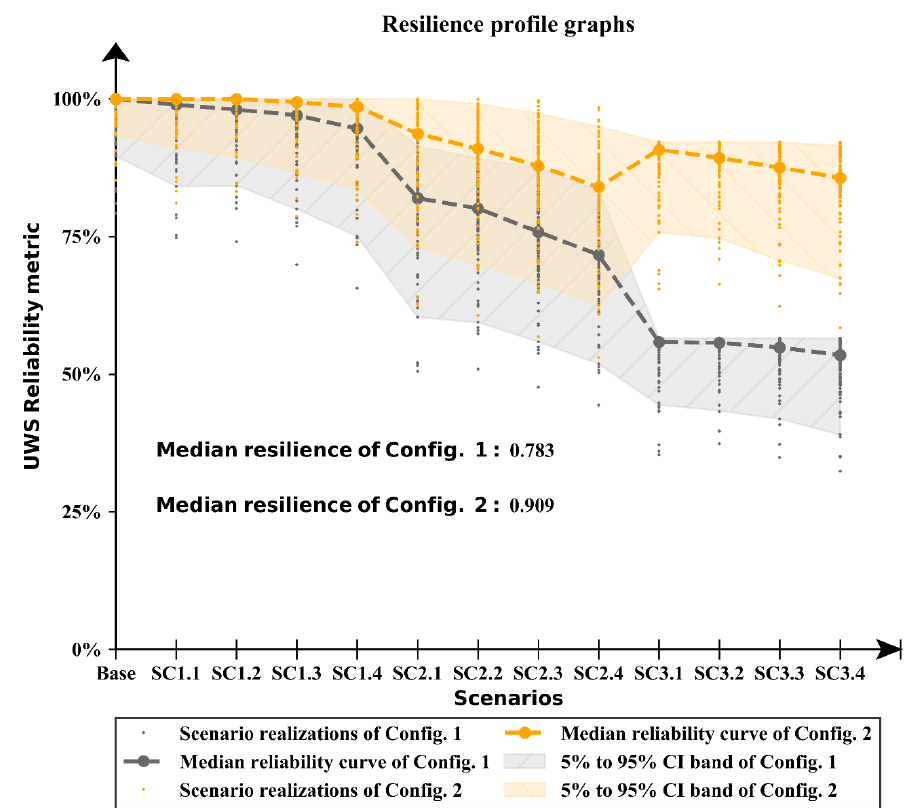
Figure 7. Resilience profile graphs with highlighted uncertainty bands. Table 3. Resilience scores for Configurations 1 and 2.